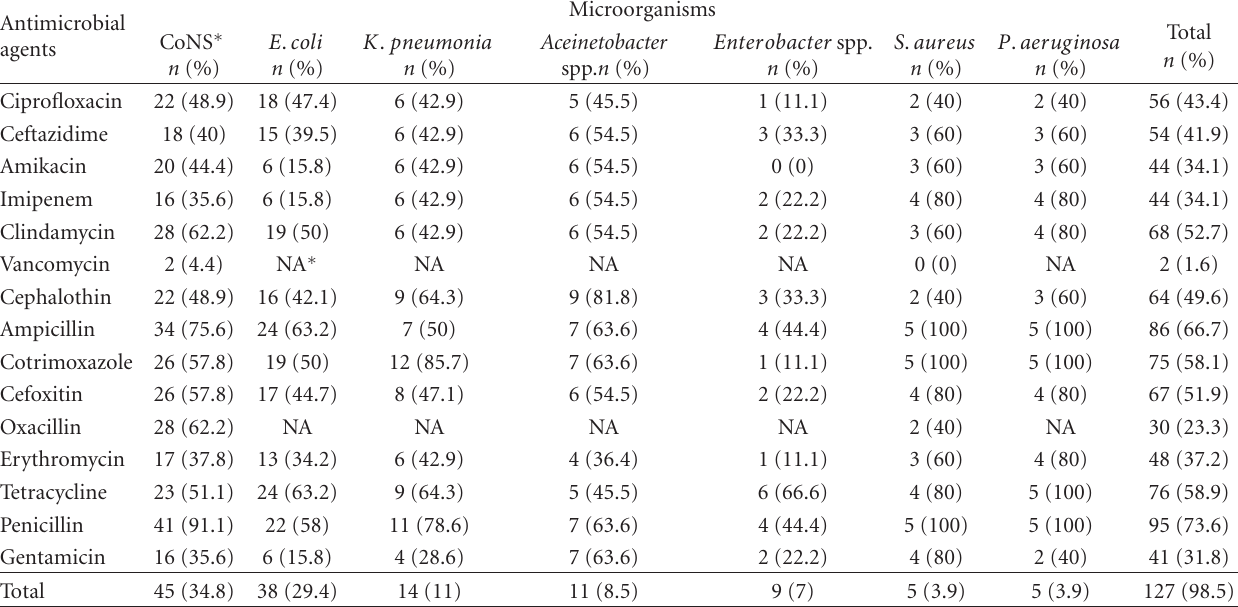
Table 1: Antimicrobial resistance profiles of hospital-acquired bacterial isolates from clinical blood specimens. Antimicrobial